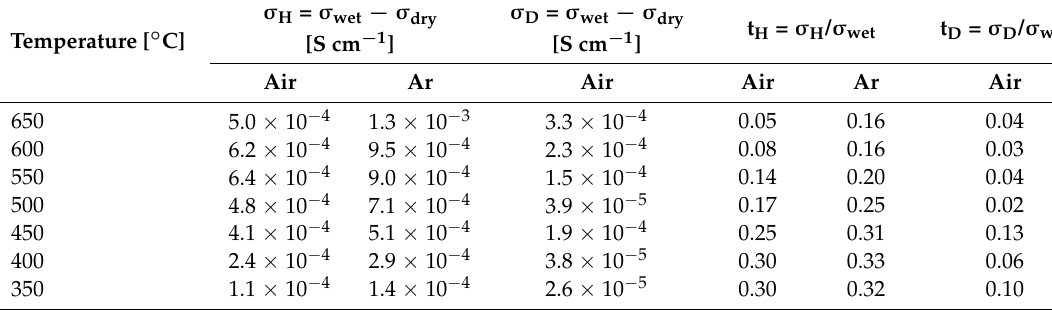
Table 2. Calculated proton ( σ H ) and deuterium ( σ D ) conductivities together with respective transference numbers (t H, t D ) for measurement conducted in synthetic air and argon.